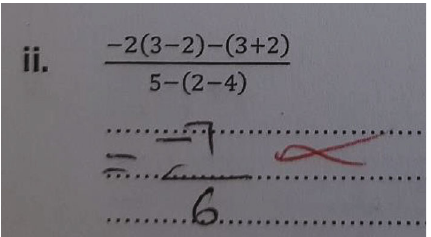
Figure 9: Learner N, School D.